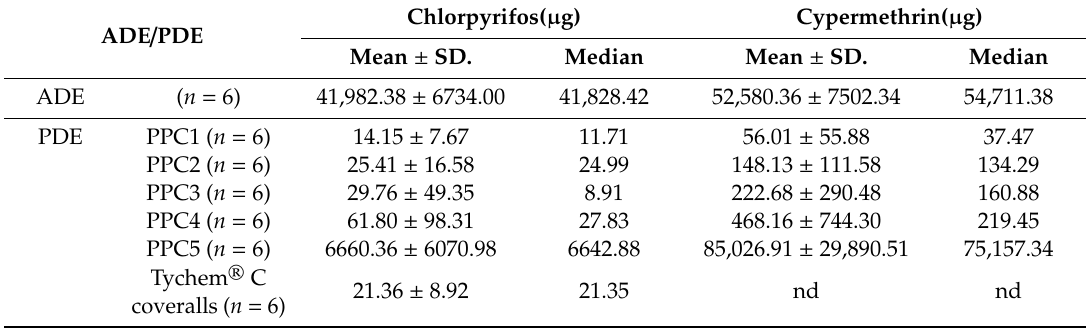
Table 2. Actual dermal exposure (ADE) and potential dermal exposure (PDE) for the total surface body